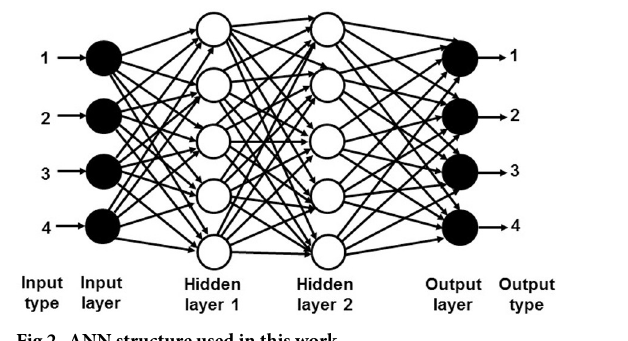
Fig 2. ANN structure used in this